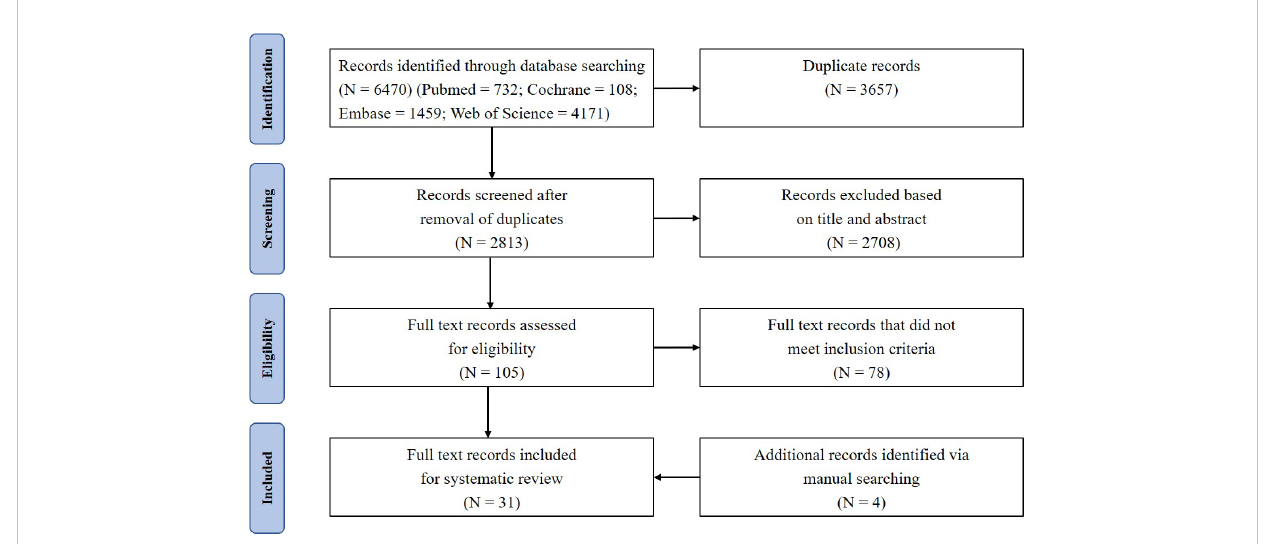
FIGURE 1 PRISMA fl ow diagram depicts the search results and selection of included studies in this systematic review.